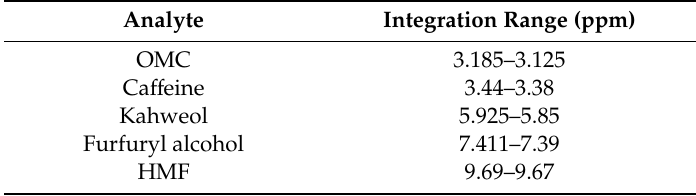
Table 4. Characteristic signals of the constituents in co ff ee and their ranges.